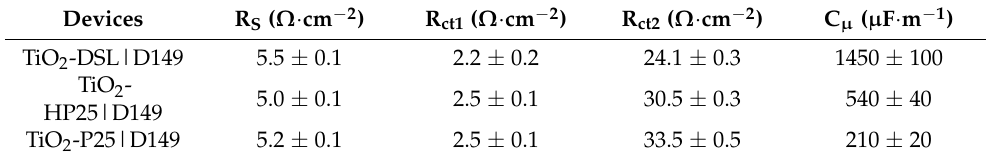
Table 3. EIS measurements of TiO 2 -DSL|D149, TiO 2 -HP25|D149, and TiO 2 -P25|D149 devices.